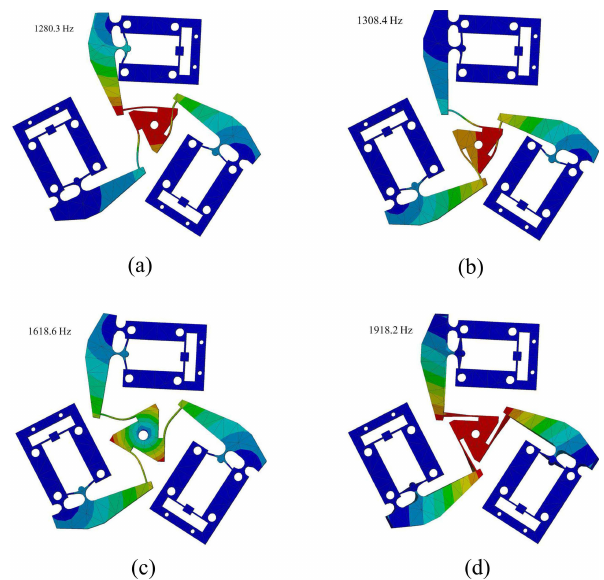
Figure 13. The lever amplification mechanism with different geo- metric